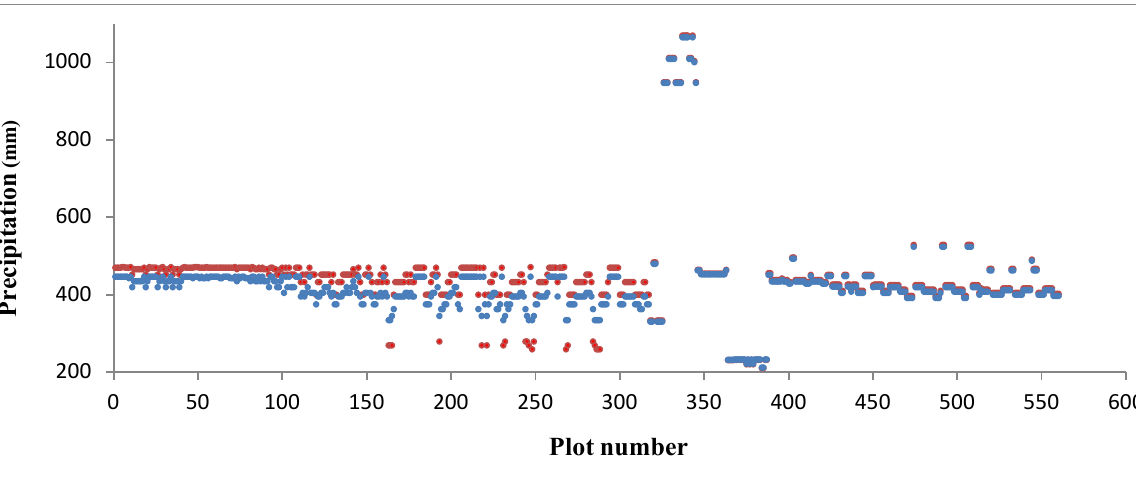
Figure 6. The trend of annual precipitation changes at the beginning (blue points) and end (red points) of the period in the studied plots.